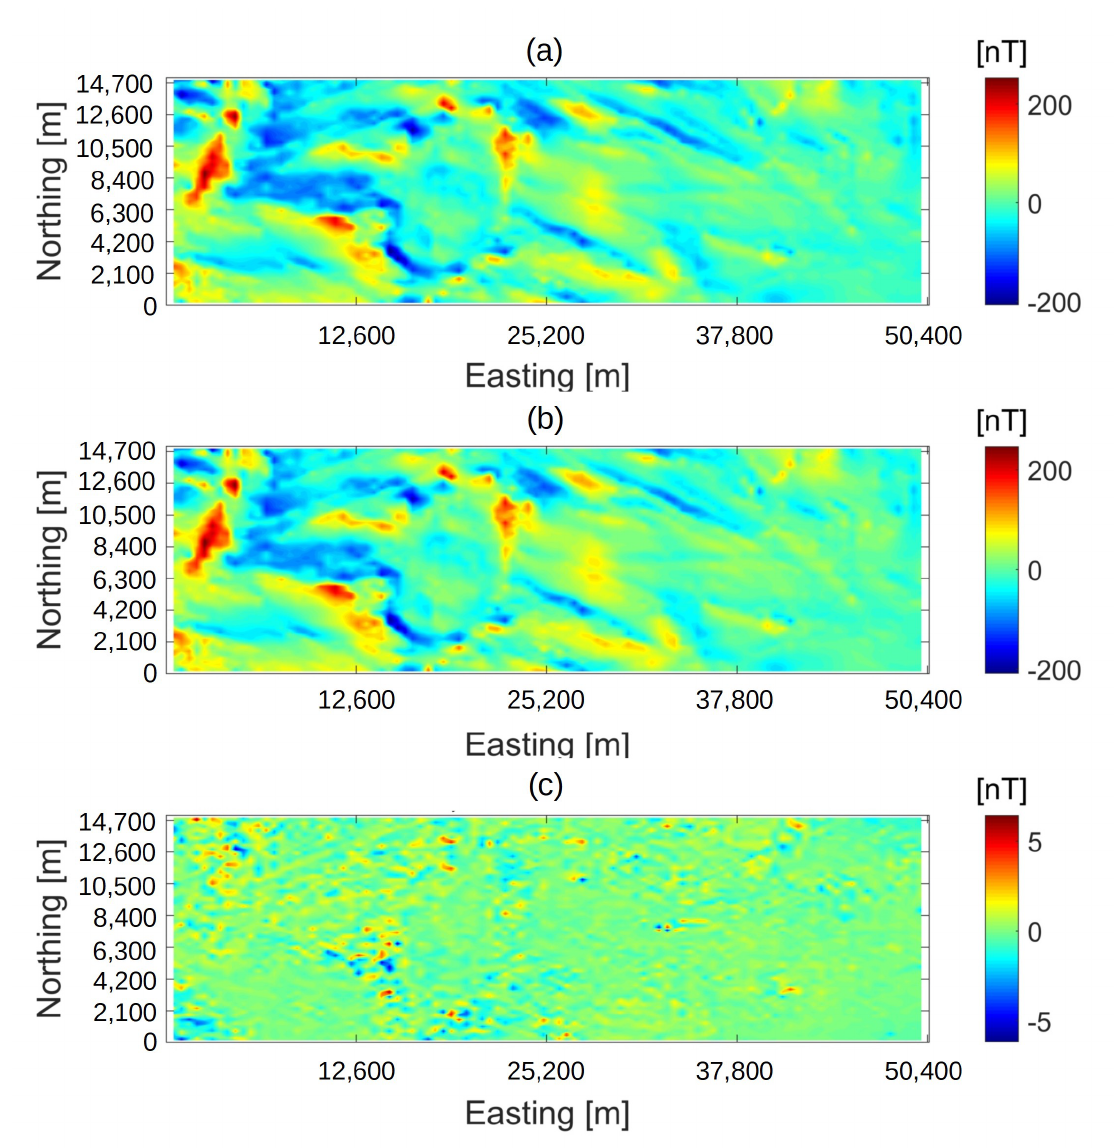
Figure 5. Examples of magnetic data fit. Panel ( a ) shows the observed total magnetic intensity (TMI) anomaly. Panel ( b ) shows the predicted total magnetic intensity (TMI) anomaly from the recovered model. Panel ( c ) shows the residual (observed minus